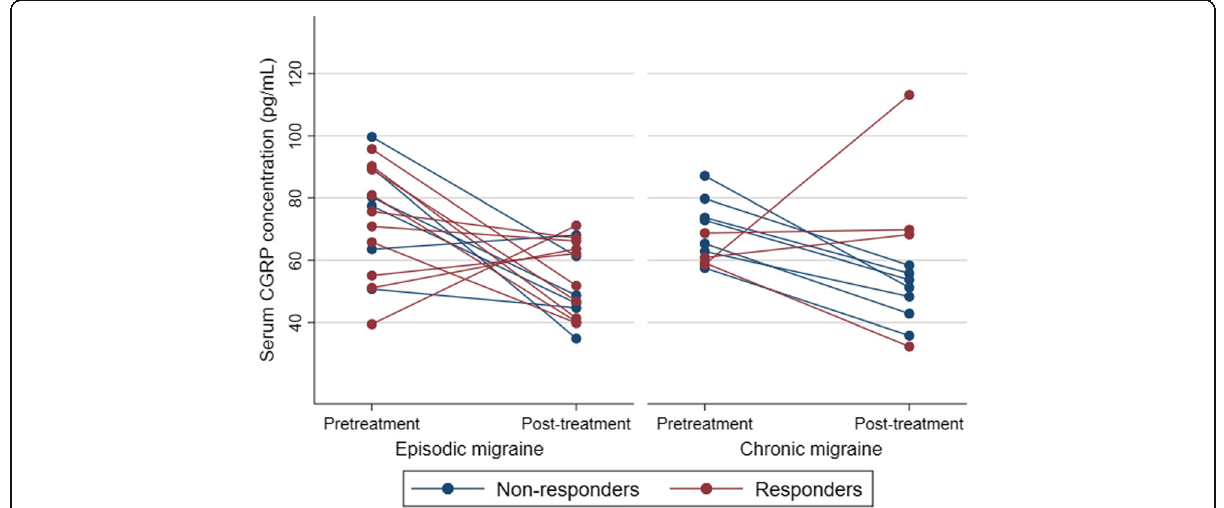
Fig. 4 Change in serum CGRP concentration. The responder was defined as > 50% reduction in monthly headache days after 3 months of